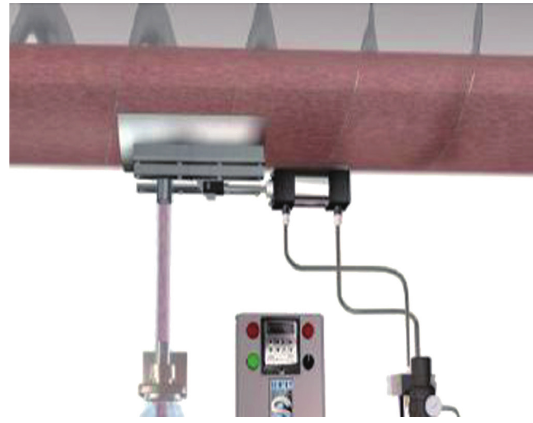
Fig. 10 Sampling a Screw Conveyor. (Courtesy of Sentry Equip- ment,